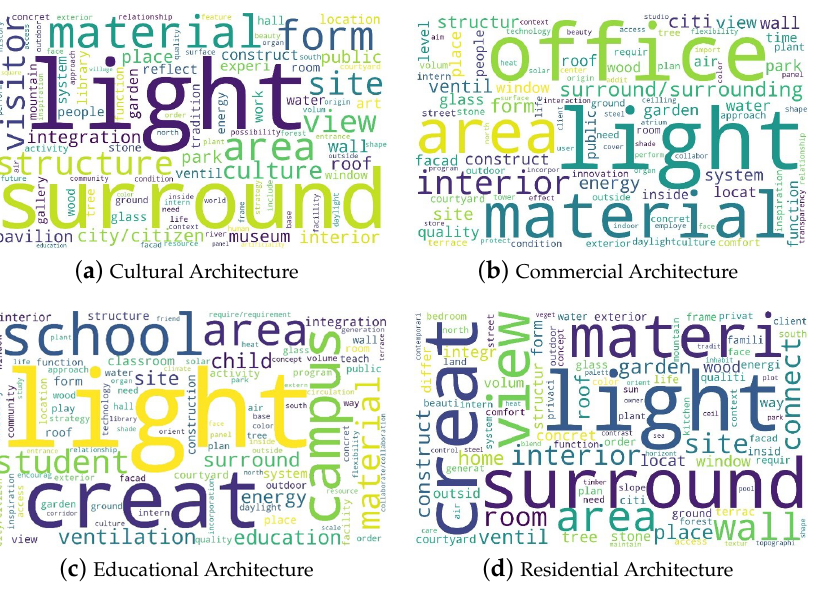
Figure 5. The word clouds for the four selected building